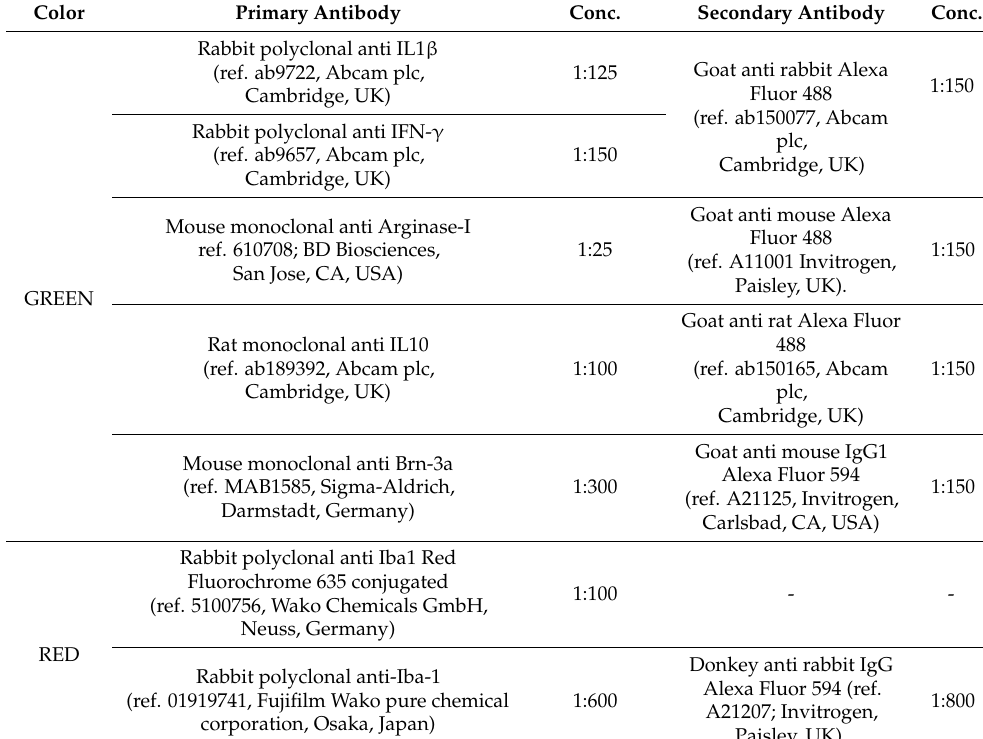
Table 1. Antibodies employed for the immunostaining